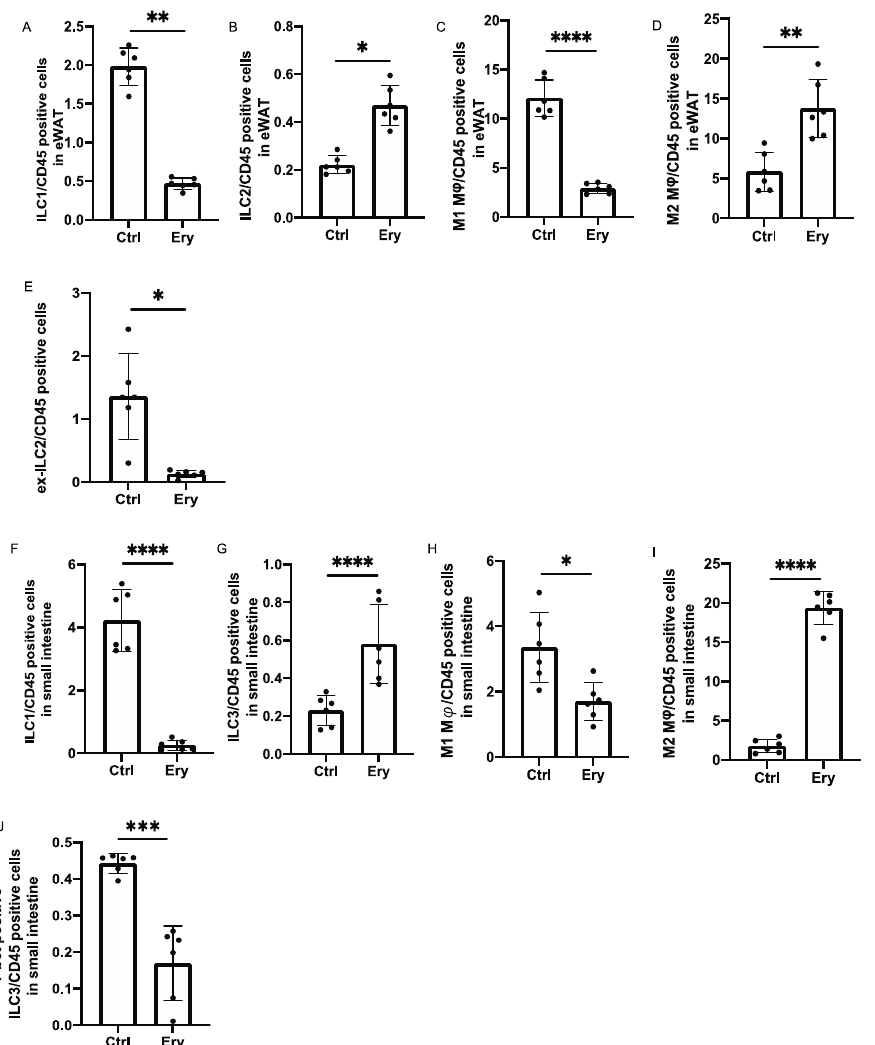
Figure 5. The Ery group had significantly lesser ILC1s and M1 macrophages in the white adipose tissue and lamina propria of the small intestine, ILC2s in the white adipose tissue, and ILC3s in the lamina propria of the small intestine than the Ctrl group. ( A ) ILC1:CD45-positive cell ratio in the epididymal white adipose tissue (eWAT) ( n = 6). ( B ) ILC2:CD45-positive cell ratio in the eWAT ( n = 6). ( C ) M1 macrophage:CD45-positive cell ratio in the eWAT ( n = 6). ( D ) M2 macrophage:CD45-positive cell ratio in the eWAT ( n = 6). ( E ) Ex-ILC2:CD45-positive cell ratio in the eWAT ( n = 6). ( F ) ILC1:CD45-positive cell ratio in the lamina propria of the small intestine ( n = 6). ( G ) ILC2:CD45-positive cell ratio in the lamina propria of the small intestine ( n = 6). ( H ) M1 macrophage:CD45-positive cell ratio in the lamina propria of the small intestine ( n = 6). ( I ) M2 macrophage:CD45-positive cell ratio in the eWAT ( n = 6). ( J ) T-bet-positive ILC3:CD45-positive cell ratio in the eWAT ( n = 6). Data have been represented in terms of mean ± SD values. * p < 0.05, ** p < 0.01, *** p < 0.001, and **** p < 0.0001, using an unpaired t